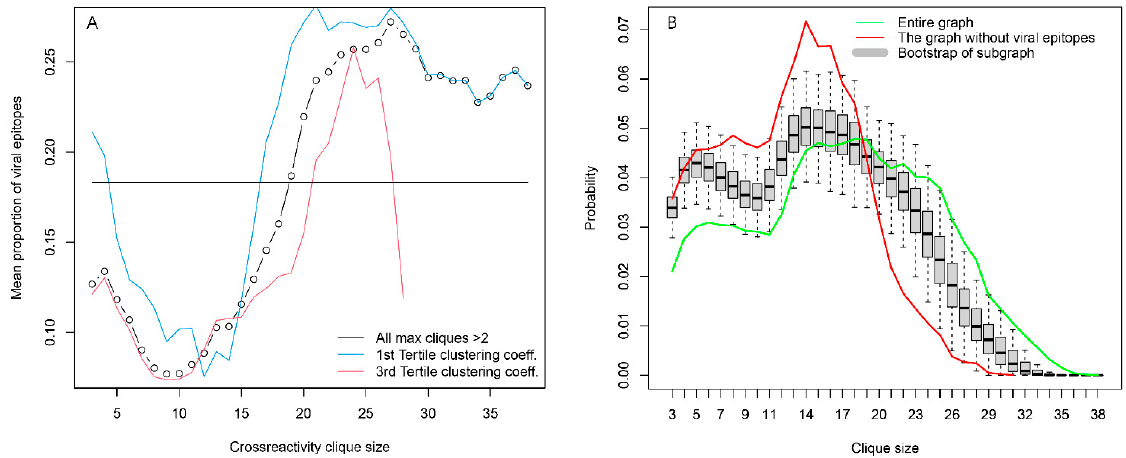
Figure 9. Viral epitopes are an important organizing element of the IgOme. ( A ) Distribution of viral epitopes as a function of clique size. They are very common in the overlapping large cliques without being over-represented in the set of peptides that are found in large cliques. This suggests that they are central elements on which many large cliques overlap. Viral epitopes are also found mostly in cliques with a lower capacity to classify the tumor patients (blue and red lines). ( B ) Viral epitope (probably preimmune) reactivities are found in many large cliques of the reactivity graph because they are most often the ones in which the large cliques overlap. Omitting them leads to a graph with significantly fewer large cliques (red line) compared to the bootstrapped-induced subgraphs lacking the same number of randomly sampled vertices.